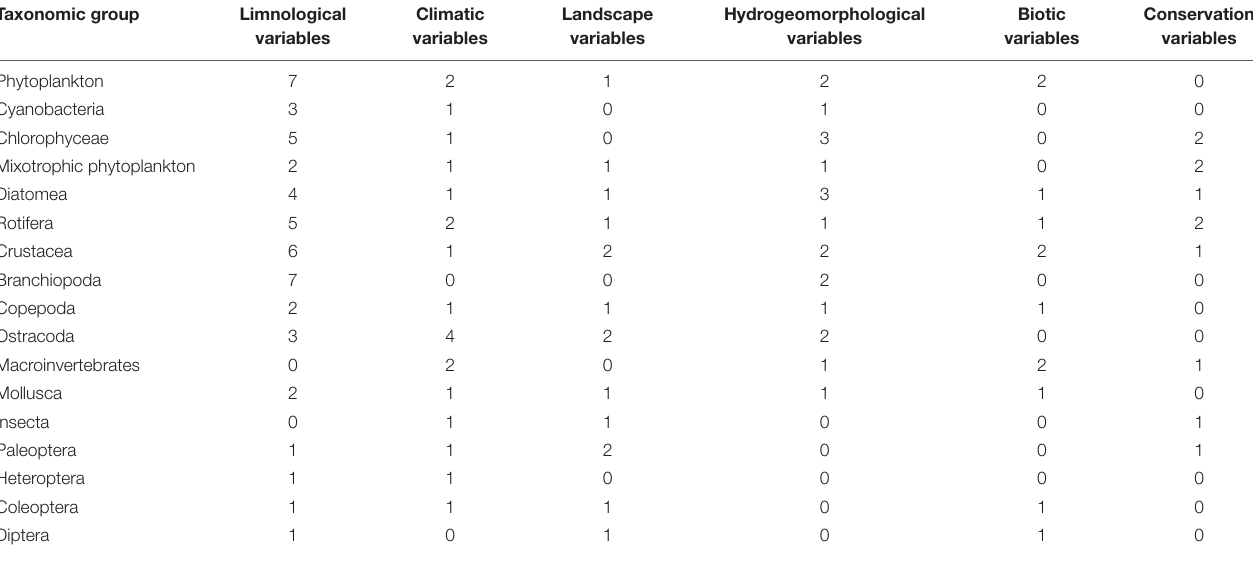
TABLE 2 | Number and type of environmental variables selected in the variation partitioning analyses for each group of organisms. Taxonomic group Limnological